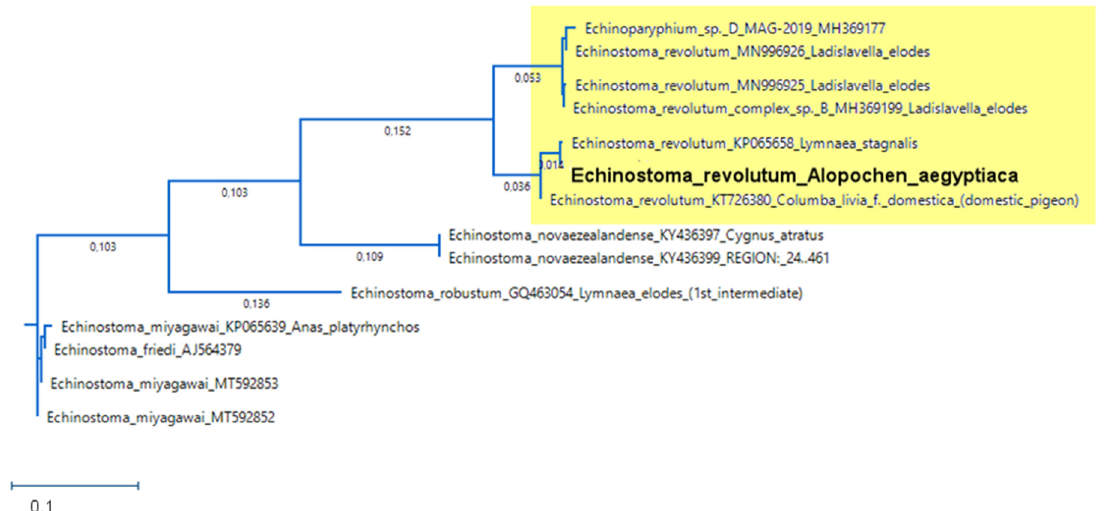
Figure 7. Species diagnosis of the specimens of Echinostoma revolutum obtained from Egyptian geese (Alopochen aegyptiaca), based on the 475-nt fragment of mitochondrial nad1 gene. The species Echinostoma revolutum is highlighted by a yellow box. The GenBank number of the obtained sequence is OQ466599. The highest similarity in the generated sequence is to a European cecarial isolate of Echinostoma revolutum ( sensu stricto ) from a freshwater snail ( Lymnaea stagnalis ) in Hamru (Czech Republic). Isolated by Georgieva et al. [66]. (ClustualW-Alignment, Maximum Likelihood tree).